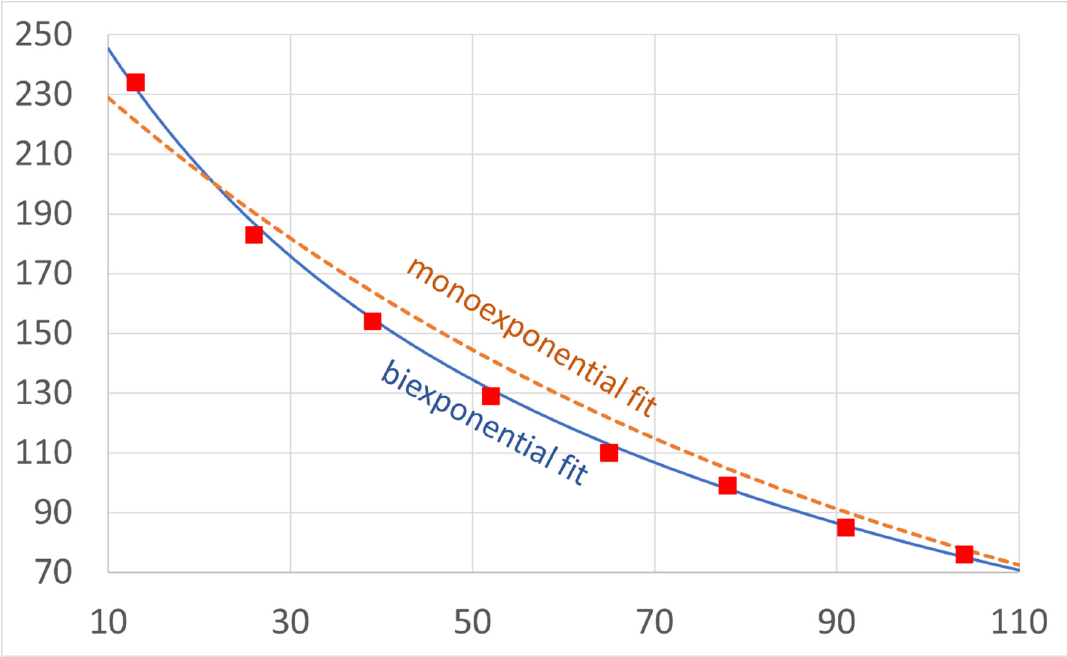
Figure 6. Comparison of mono- (dashed line) and bicomponent (solid line) fitting curves for eight exemplary echo time points (squares) showing a higher error for the monoexponential fit.